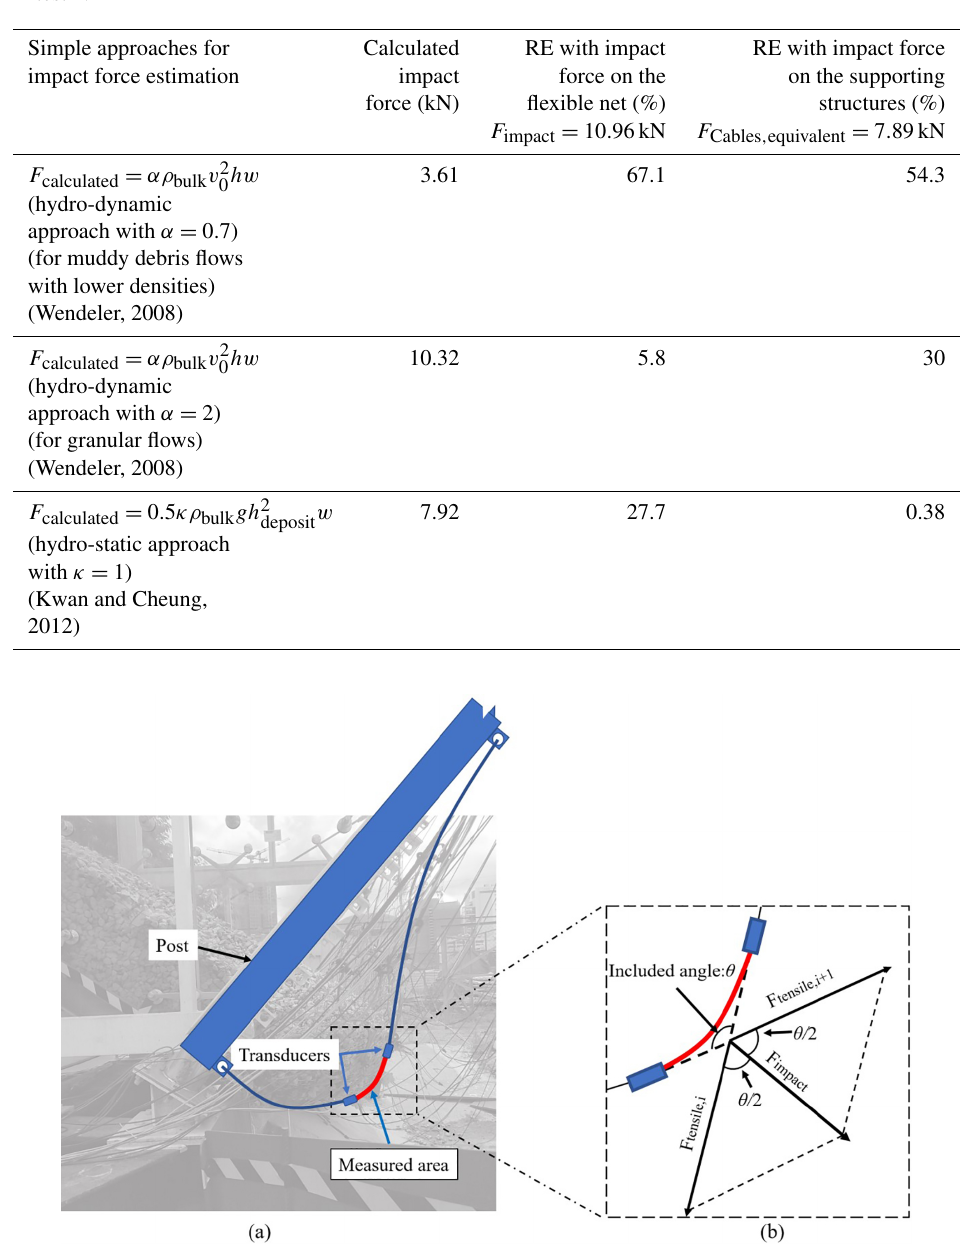
Table 3. Comparisons of the calculated impact forces using simple approaches with the measured impact forces on different components of a flexible barrier in test 1.